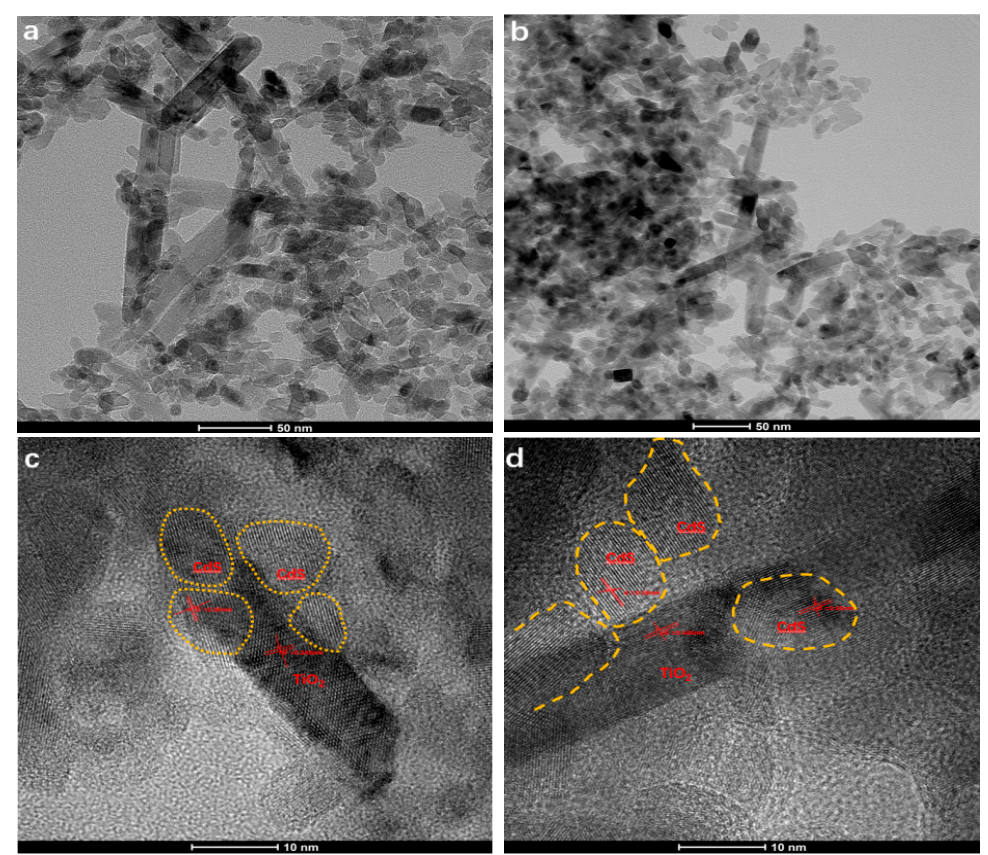
Figure 2. TEM patterns of TiO 2 (40%)@CdS composites( a – d ).